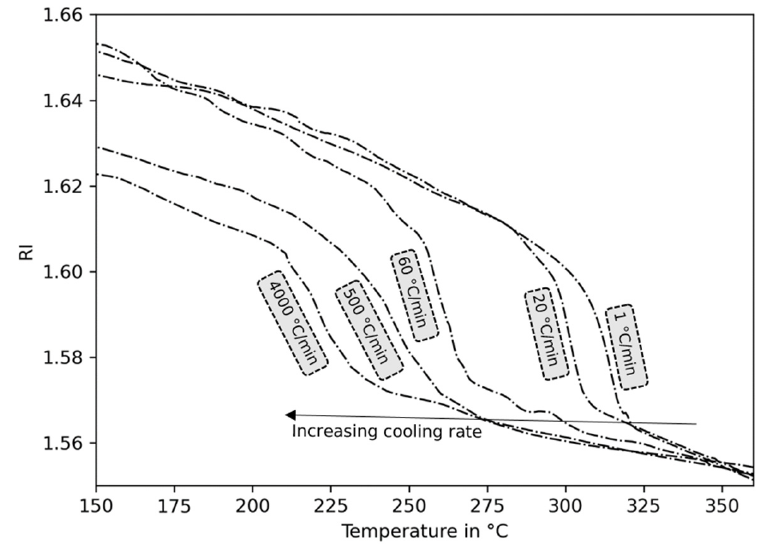
Figure 11. Refractive index (RI) of PEEK at different cooling rates.